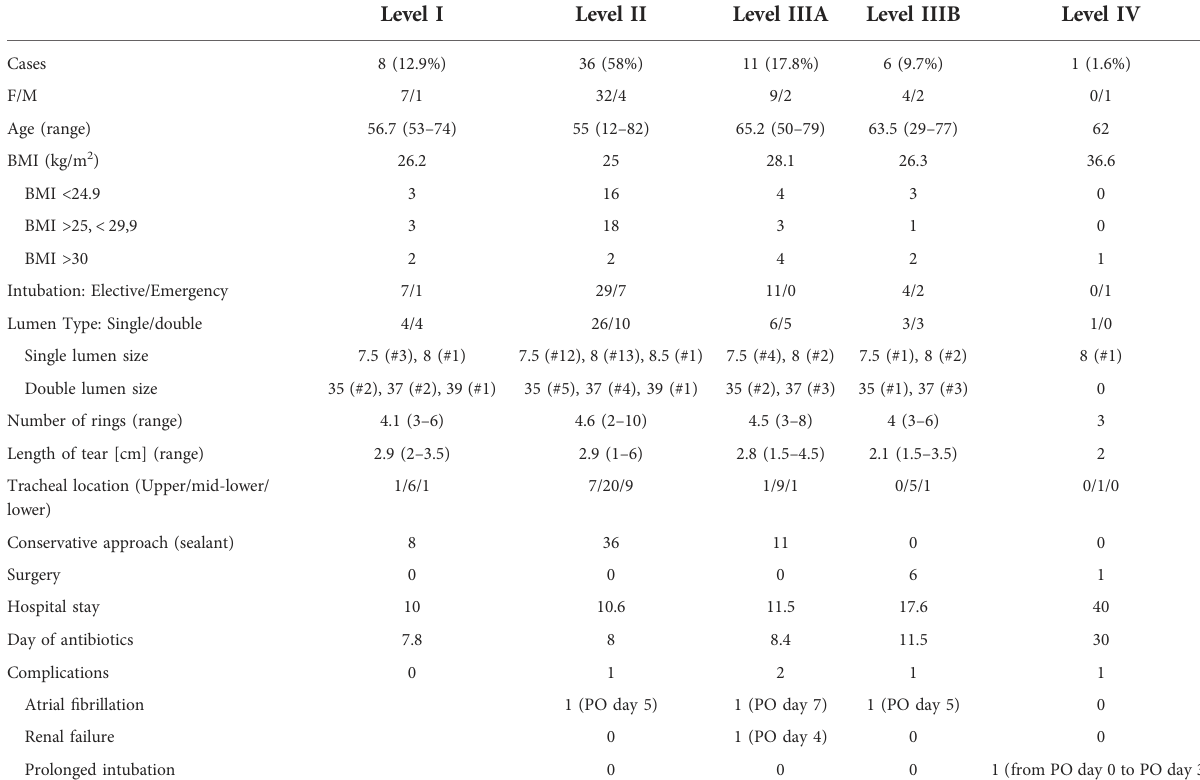
TABLE 2 Patient characteristics, according to PITL level.